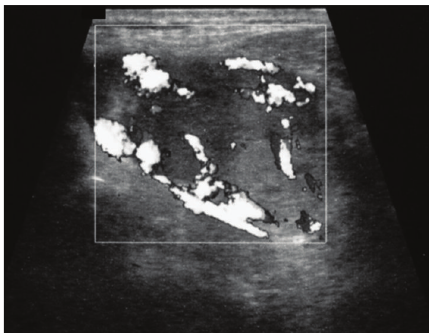
Figure 1: Thyroid ultrasonography showing a left 5cm solid and isohypoechoicnodulewithperipheralandintranodularvasculariza- tion.